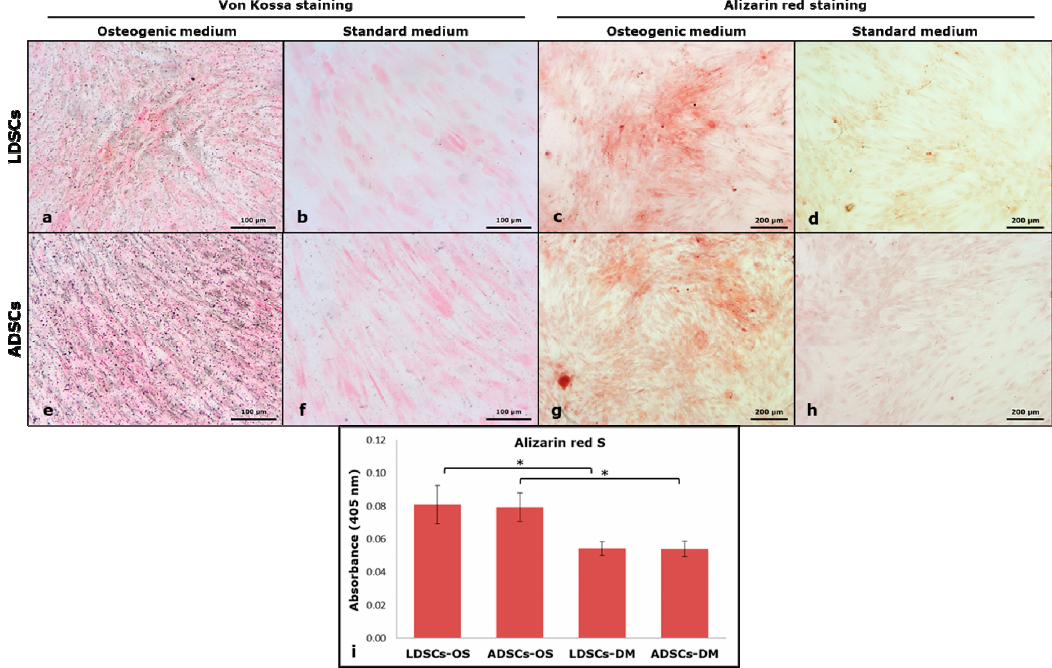
Figure 10. Von Kossa staining of cells at day 16 of osteogenic differentiation; LDSCs in osteogenic medium (OS) ( a ) LDSCs in standard medium (DM) ( b ) ADSCs in OS medium ( e ) and ADSCs in DM medium ( f ); dark grey/black deposits’ color in ( a ) and ( e ) indicates positive staining; Alizarin red S staining of cells at day 16 of osteogenic differentiation; LDSCs in OS medium ( c ) LDSCs in DM medium ( d ) ADSCs in OS medium ( g ) and ADSCs in DM medium ( h ); red deposits’ color in ( c ) and ( g ) indicates positive Alizarin red S (ARS)staining; All images were acquired at bright